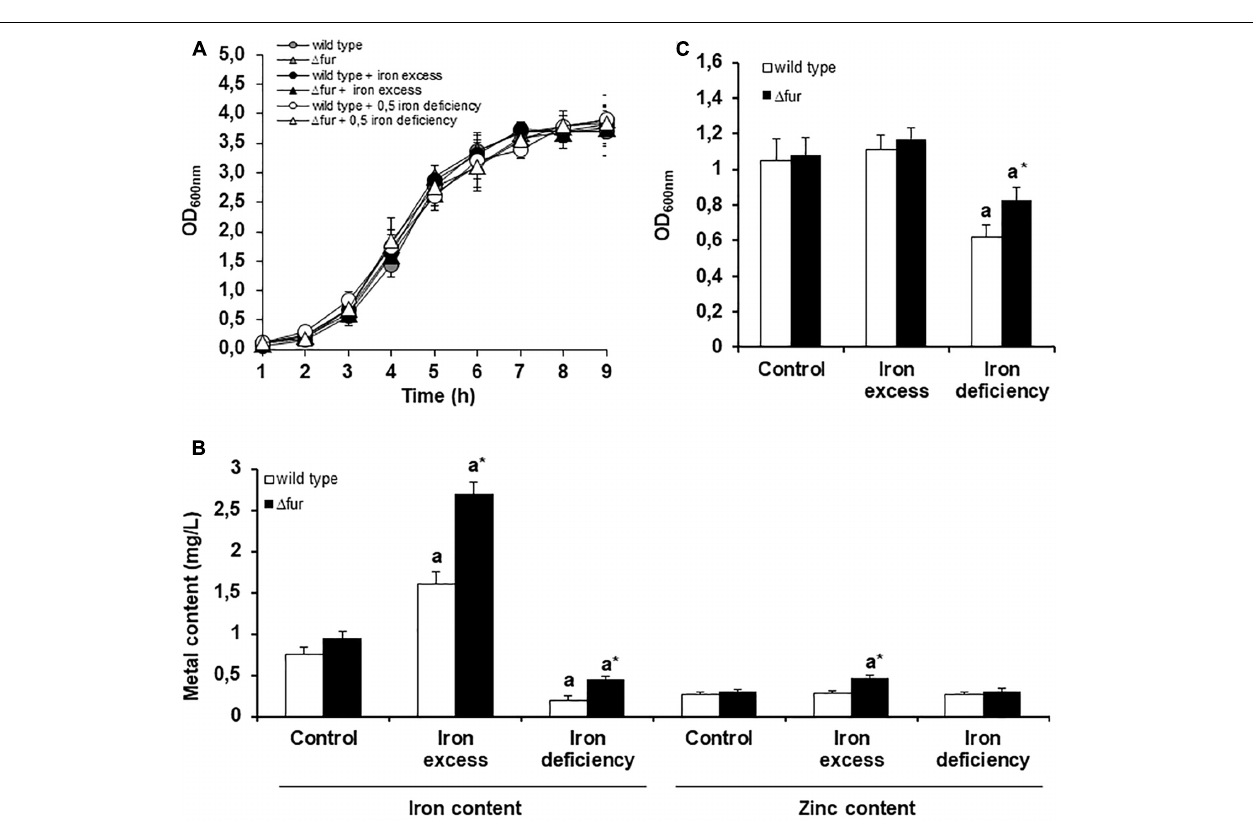
FIGURE 2 | Homeostatic response of E. faecalis wild type and (cid:49) fur (Fur mutant) under different iron conditions. (A) Growth curve of E. faecalis wild type and (cid:49) fur under three iron exposure conditions. (B) Biofilm assay, optic density was measured after 24 h. (C) Bacterial metal content measured after 3 h of iron exposure. Letter a denotes significant difference between the control media and iron excess or deficit for the same strain. Asterisk ( ∗ ) marks significant difference between the wild type and (cid:49) fur for the same growing condition of iron. Error bars represent standard deviation (SD) values. Three biological replicates (Mann–Whitney test, p < 0.05).